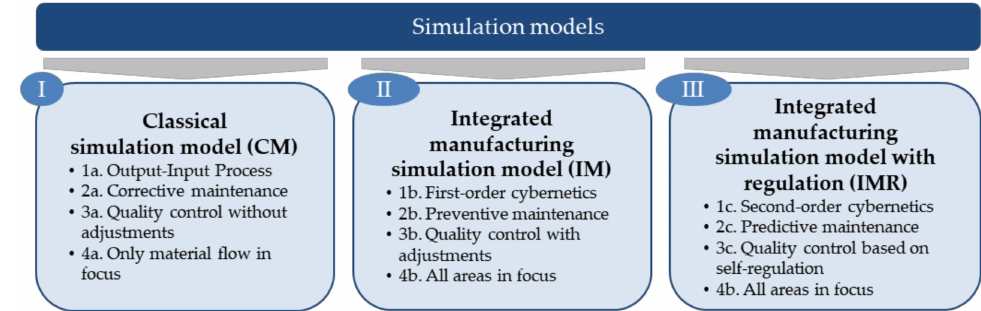
Figure 6. Simulation models (own